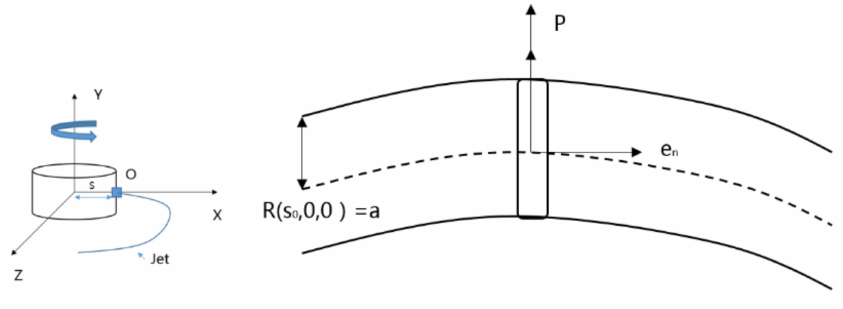
Figure 4. Schematic diagram of jet flow and jet cross-section in a Cartesian coordinate